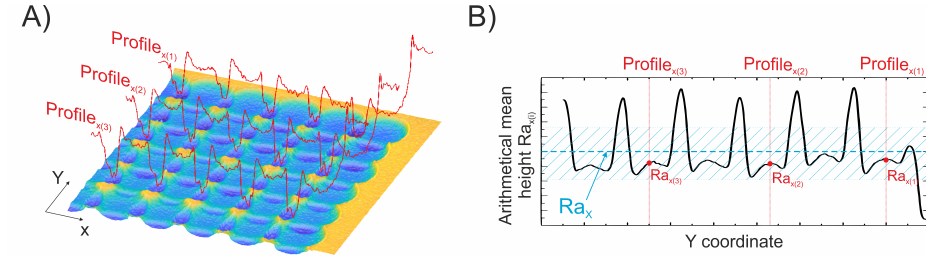
Figure 3. Scheme explaining how surface roughness is evaluated. The topography of a sample after single scan machining, when the overlap of the modifications is low, is shown in part ( A ). Red curves represent profiles at discrete locations. Surface roughness dependence on Y coordinates is depicted in part ( B ). Ra x(j) is a roughness parameter of a j profile. The roughness of an area is then the average ( Ra X ). Blue dashed line shows the position of Ra X on the y-axis, where tilted blue lines represent the range of one standard